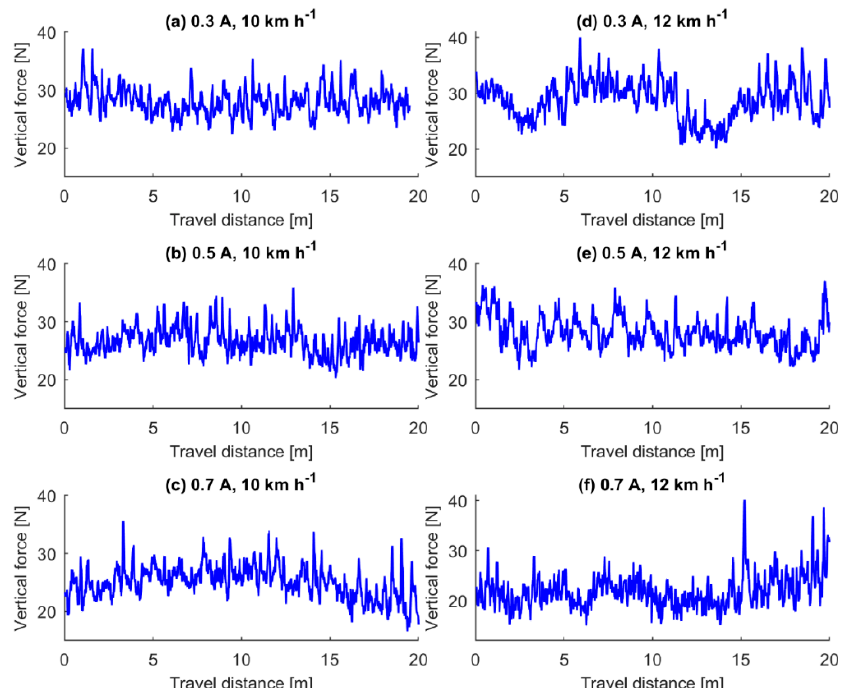
Figure 5. The measured vertical forces at the speed of ( a – c ) 10 km h − 1 and ( d – f ) 12 km h − 1 , when the MR damper was supplied with 0.3 A, 0.5 A, and 0.7 A.